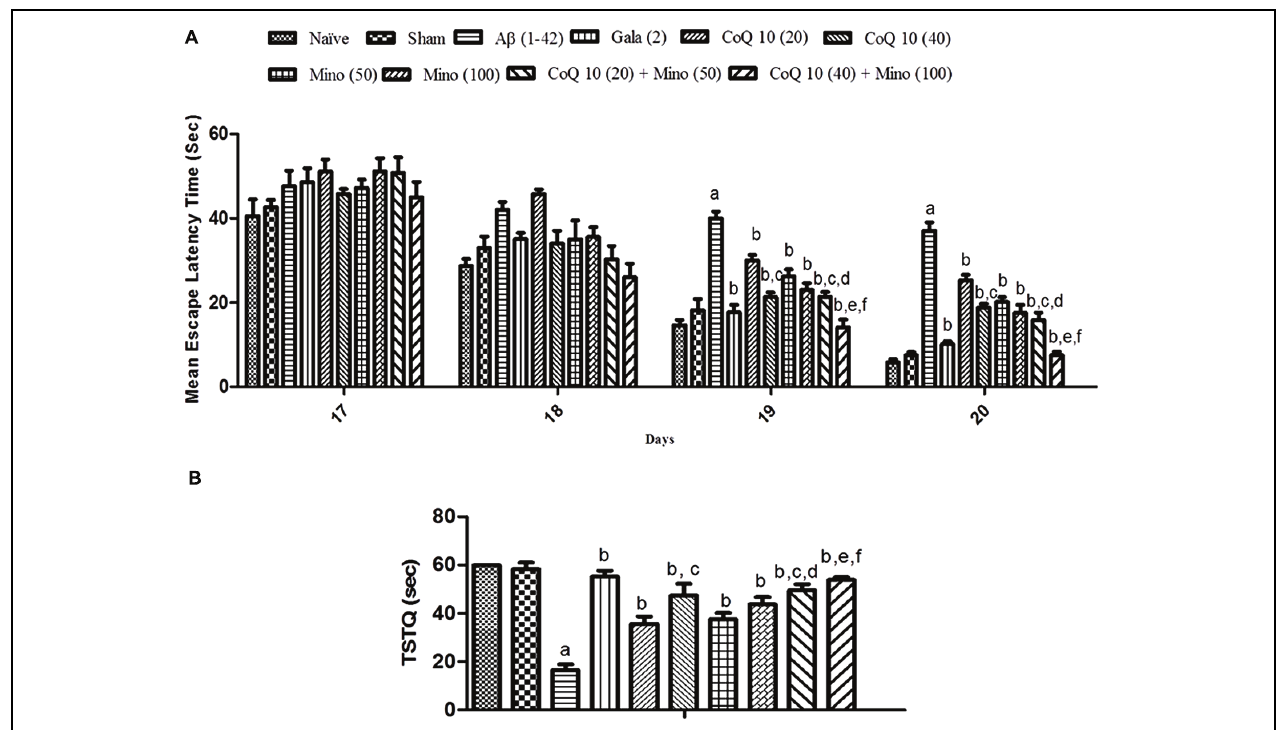
FIGURE 2 | (A) Effect of CoQ10 and minocycline alone and in combination on memory performance in Morris water maze acquisition phase in A β (1-42) treated rats. Data expressed as mean ± SEM a P < 0.05 compared to sham group, b P < 0.05 compared to A β (1-42) treated group, c P < 0.05 compared to CoQ10 (20) group, d P < 0.05 compared to Mino (50) group, e P < 0.05 compared to CoQ10 (40); f P < 0.05 compared to Mino (100) group (Two way ANOVA followed by Bonferroni’s t -test). (B) Effect of CoQ10 and minocycline alone and in combination on time spent in the target quadrant (TSTQ) in the Morris maze retention phase (21st day) in A β (1-42) treated rats. Data expressed as mean ± SEM a P < 0.05 compared to sham group, b P < 0.05 compared to A β (1-42) treated group, c P < 0.05 compared to CoQ10 (20) group, d P < 0.05 compared to Mino (50) group, e P < 0.05 compared to CoQ10 (40), f P < 0.05 compared to Mino (100) group (One way ANOVA followed by Tukey’s test). (A β , Amyloid beta; Gala, Galantamine; CoQ10, Coenzyme Q 10; Mino, Minocycline).